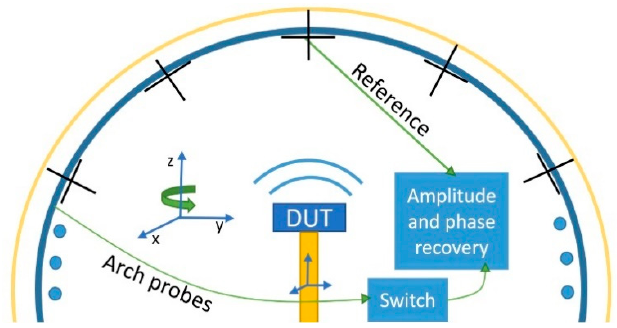
Figure 1. Multiprobe set ‐ up for phase